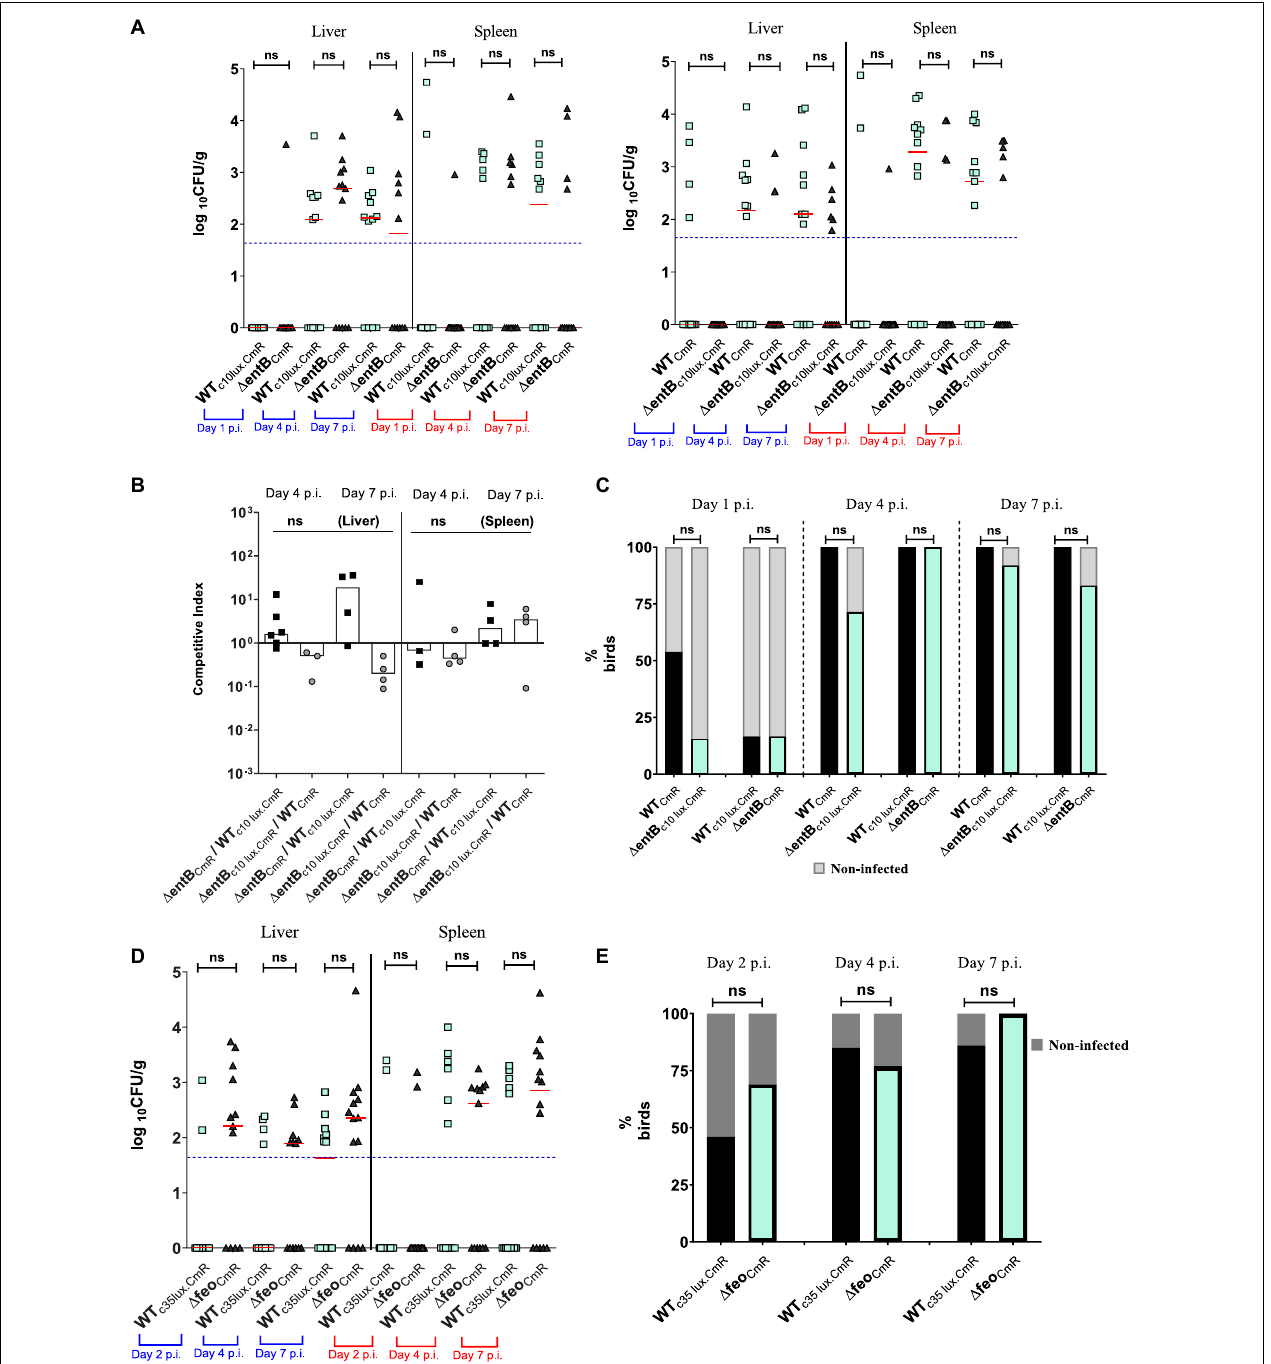
FIGURE 4 | (A) Wildtype or (cid:49) entB burden in liver and spleen by direct plating. Each symbol represents a log 10 CFU value related to a mutant or wildtype strain. Due to co-infection each bird (12–14 birds per time point) has two matching pair values of CFU not shown in here. Median value of the data set shown by horizontal bar. Detection limit has shown by dotted horizontal line (50 CFU/g). Mean differences were accounted for analysis. ns, not significant. (B) Competitive index scores for (cid:49) entB vs. wildtype SEn strain. CI values were calculated only from sample which showed recovery from direct plating. Column indicates the median value for the data set. (C) Infectivity of wildtype or (cid:49) entB obtained by liver and spleen enrichments. Dark column represents % birds for infected by the strain which are recovered by liver/spleen enrichments. Non-infected % of birds presented by shaded gray color columns means that strain was not recovered by enrichments. (D) Wildtype or (cid:49) feo burden in liver and spleen by direct plating. Each symbol represents a log 10 CFU value related to a mutant or wildtype strain (13–14 birds per time point). Description of data presentation follows as (A) . (E) Infectivity of wildtype or (cid:49) feo obtained by liver and spleen enrichments. Description of data presentation follows as (C)